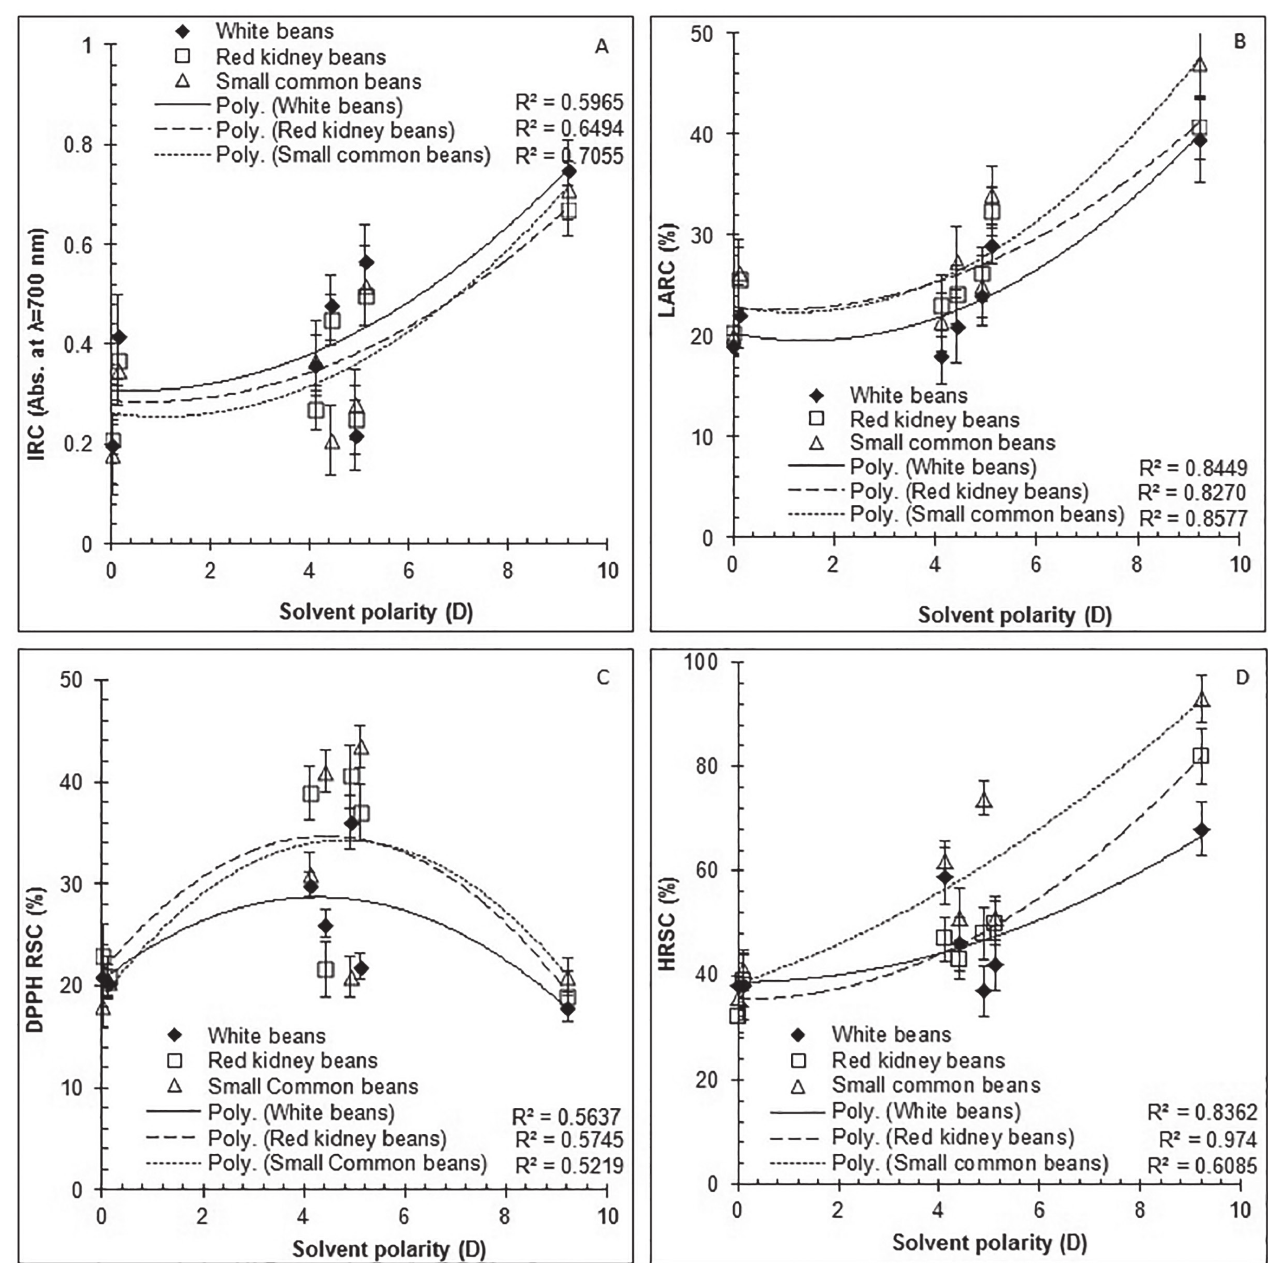
FIGURE 3 - Reducing capacity and free radical scavenging capacity of three varieties of bean seeds at various levels of solvent polarity. A: Iron reducing capacity (IRC), B: Linoleic acid reduction capacity (LARC), C: Hydroxyl radical scavenging capacity (HRSC), D: DPPH radical scavenging capacity (DPPH